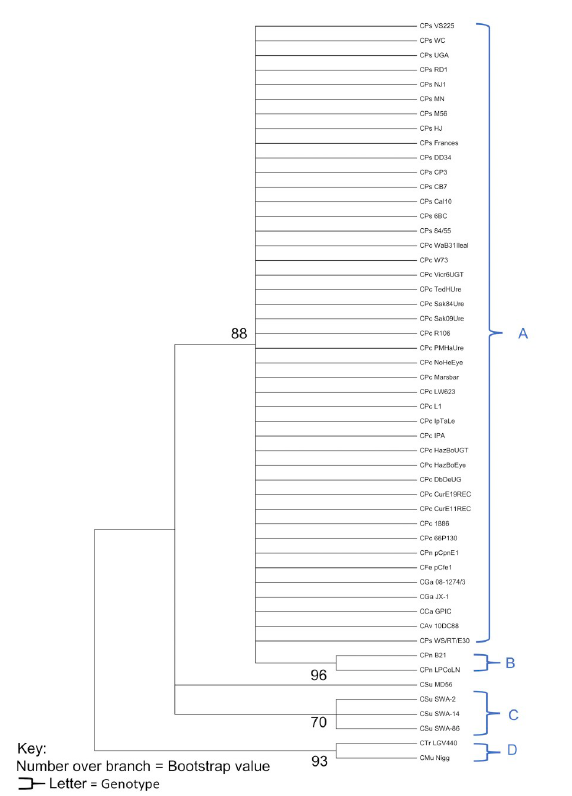
Fig 6. The maximum likelihood estimate for 51 iteron plasmid strains with a log likelihood of log (-215.66).